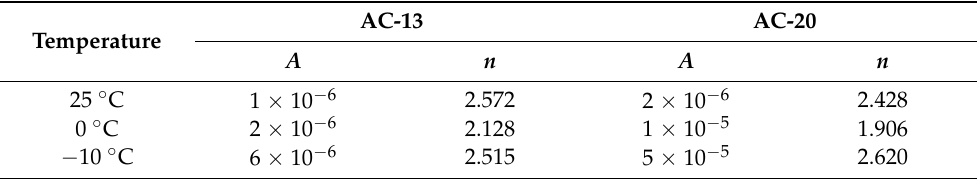
Table 7. Fracture parameter calculation.